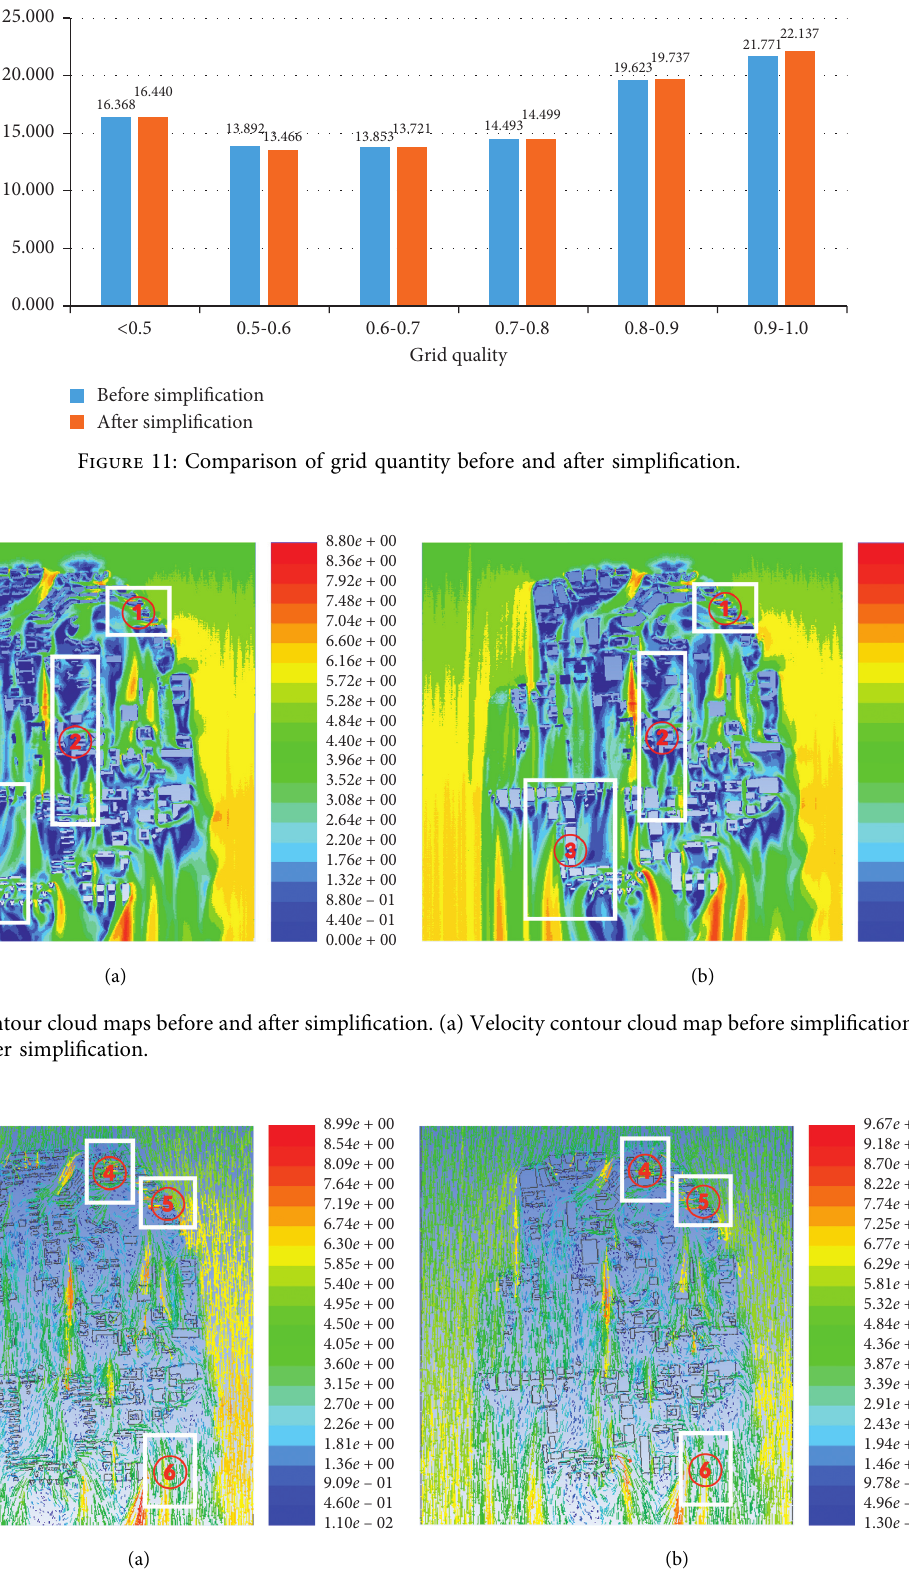
Figure 13: Velocity vector maps before and after simplification. (a) Velocity vector map before simplification. (b) Velocity vector map after simplification.